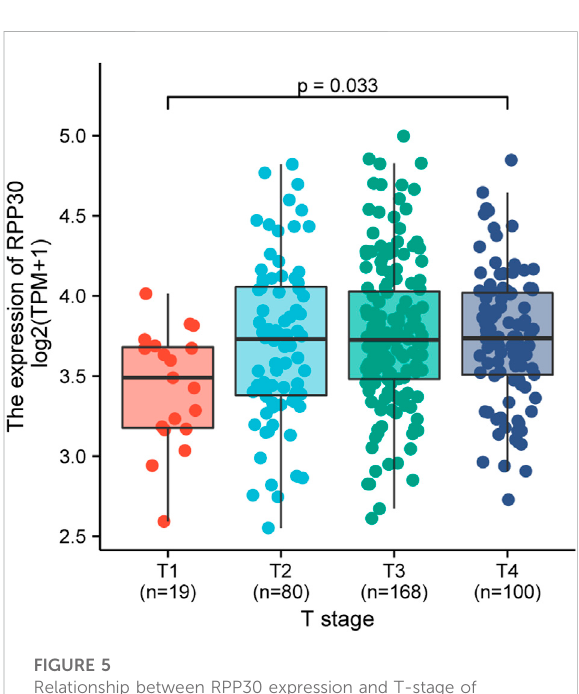
FIGURE 5 Relationship between RPP30 expression and T-stage of TCGA in GC. The results showed that RPP30 expression was signi fi cantly correlated with T-stage ( p = 0.033). Bonferroni correction between each group also showed signi fi